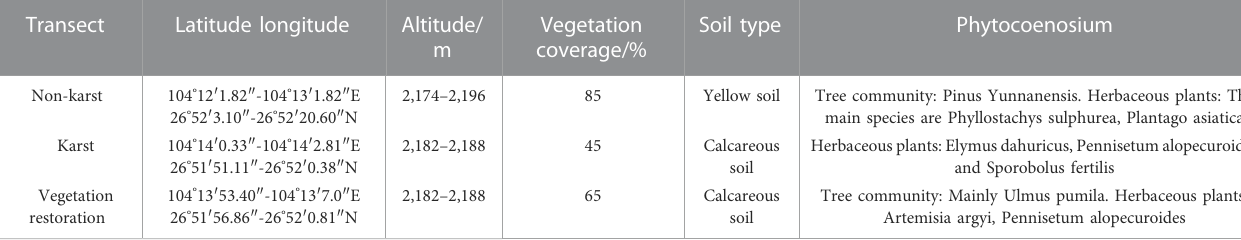
TABLE 1 Location and vegetation status of the